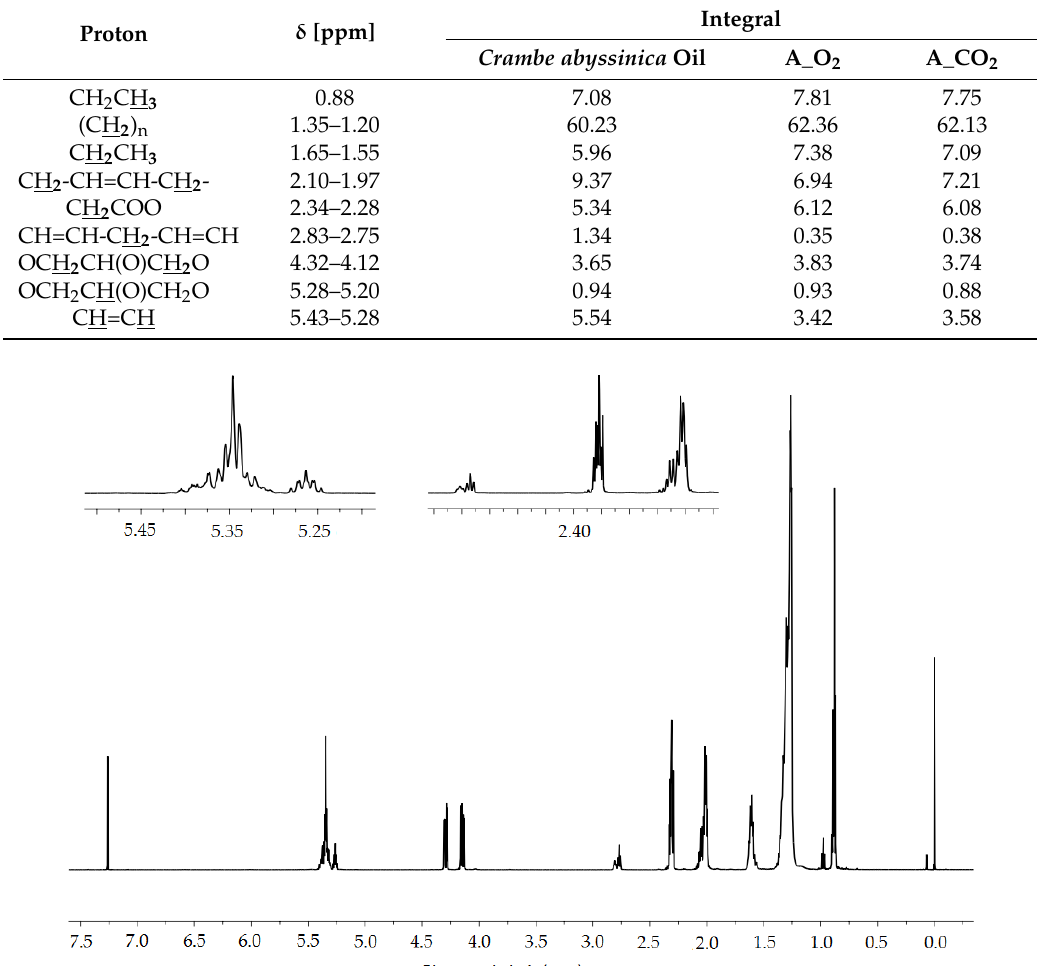
Table 4. Chemical shifts and integral values in 1 H-NMR spectra of crude oil A and oils after oxidation (A_CO 2 in the presence of CO 2 and A_O 2 without CO 2 ).